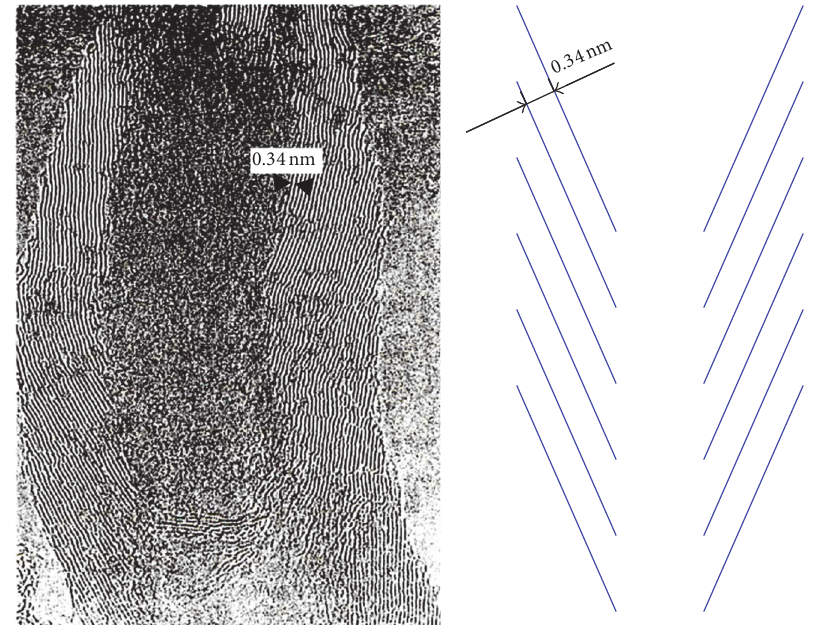
Figure 2: TEM image and schematic view of a fragment of conical carbon nanotube.